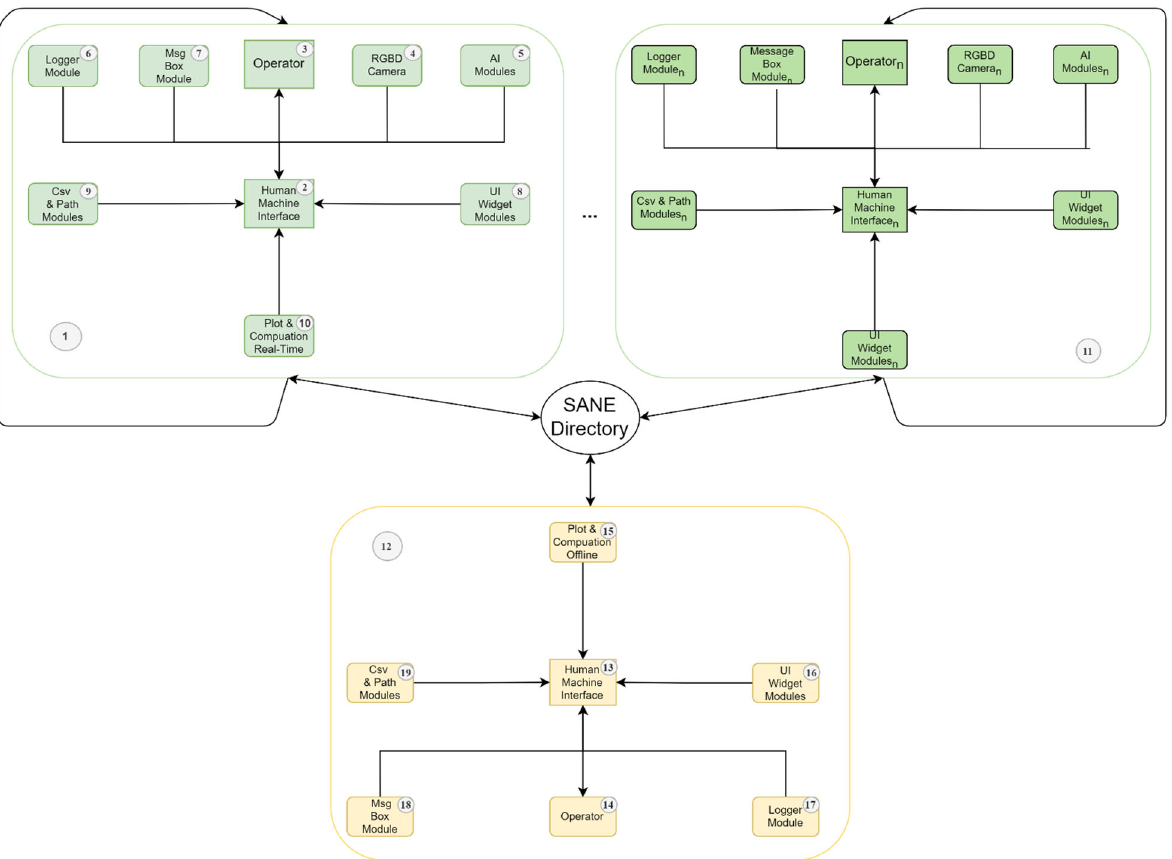
Figure 1. Proposed methodology.